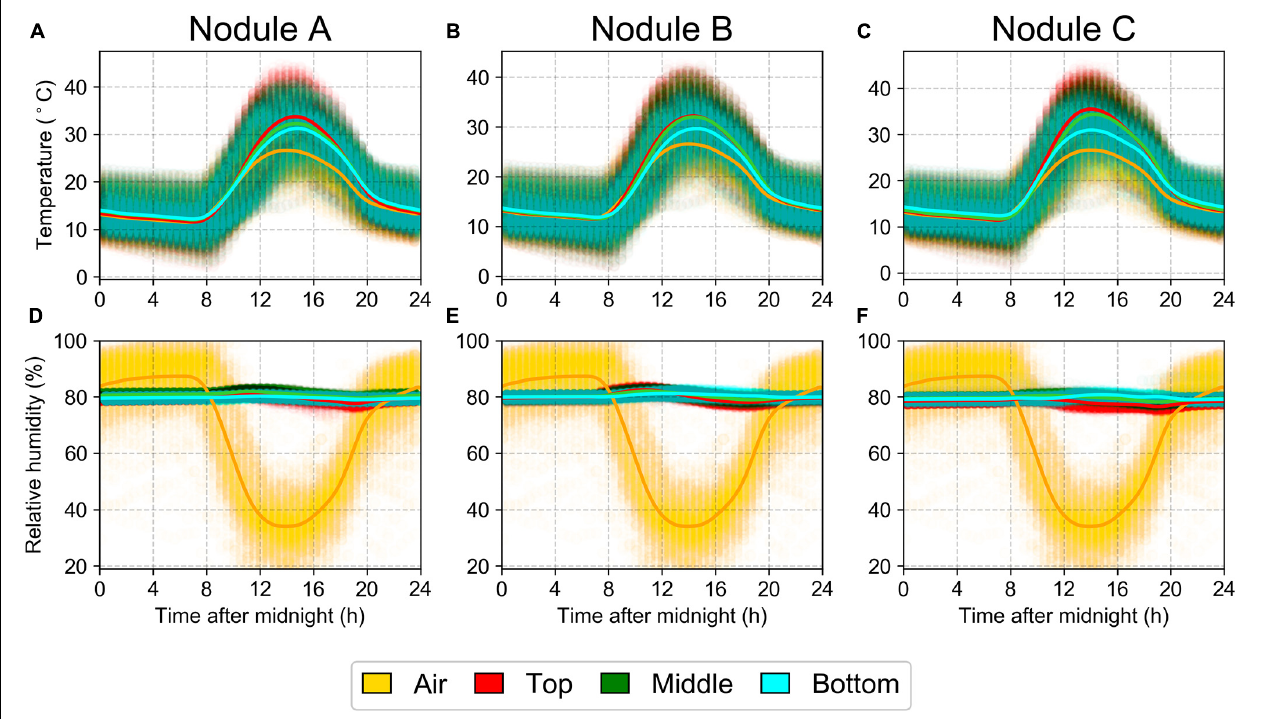
FIGURE 2 | Daily average over a year (March 25, 2019 to March 11, 2020) of temperature (A–C) and relative humidity (D–F) at North-Top sampling location inside three halite nodules (columns). Data were collected with separate HOBO sensors 1m above the ground (“Air”) or sealed inside a halite nodule near the top, middle, and bottom of the nodule. Highlight lines represent non-parametric polynomial kernel regression ( q = 6) with pyqt_fit.